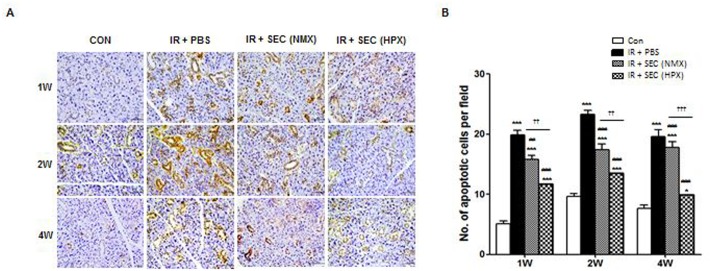
hAdMSC secretome exerts cytoprotection via anti-apoptotic effects on salivary parenchymal cells in vivo.(A) Representative images of an in vivo TUNEL assay from three experimental groups at 1, 2, and 4 weeks post-IR. Scale bars represent 50 μm. (B) The number of TUNEL-positive apoptotic cells was determined by a blinded researcher. Data are presented as the mean number of apoptotic cells per field ± SEM. Two-way ANOVA, Bonferroni post hoc test. *, compared to CON; #, compared to IR + PBS; †, compared to IR + NMX. *P <0.01, ***P <0.001, ##P < 0.01, ###P < 0.001, ††P<0.01, †††P<0.001. CON, normal control group (n = 21 sections); IR+ PBS, PBS-treated group (n = 21 sections); IR + SEC (NMX), IR + normoxic secretome-treated group (n = 15 sections); IR + SEC (HPX), hypoxia-conditioned secretome-treated group (n = 18 sections).